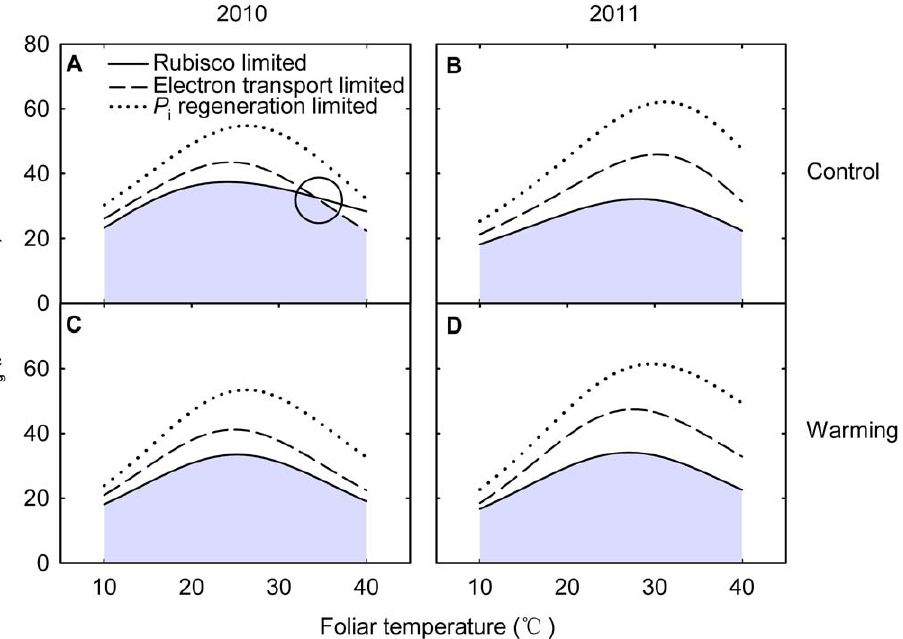
Figure 8. Warming effects on the responses of biochemical limitations in gross CO 2 assimilation ( A g ) to foliar temperature ( T leaf ) at chloroplast partial pressure of CO 2 ( C c ) of 250.8 ppmv in 2010 (left panels) and 2011 (right panels). The top panels indicate the control plots and the lower panels for the warming plots. C c was set at 250.8 ppmv considering that the mean C c / C a ratio was 0.66 at ambient CO 2 concentration (380 ppmv) for all the A n / C i curves measured. The response of A g is delineated by the minimum value of either Rubisco-limited (solid curve), ribulose bisphosphate (RuBP) regeneration-limited (dashed curve) and P i regeneration-limited (dotted curve). Circle indicates co-limited point, moving from the Rubisco-limited state to RuBP regeneration-limited state.